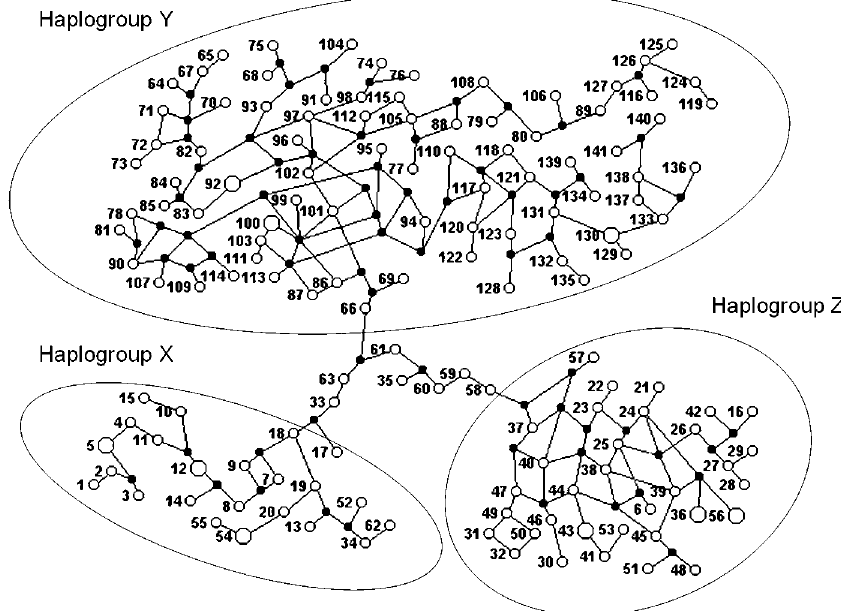
Figure 4. Median Joining Network of the Haplotypes Identified by the PHASE Software DOI: 10.1371/journal.ppat.0020024.g004 Nuclear genetic typing. Amplification of five previously described microsatellite loci , denominated SCLE10, SCLE11, MCLE01, MCLF10, and MCLG10, was performed as previously described [30]. After the PCR, the amplified microsatellites were loaded on a 6% denaturing polyacrylamide gel and analyzed on an ALF sequencer (GE Healthcare, Milwaukee, Wisconsin, United States) using the Allelinks software (GE Healthcare). To determine the allele size the samples were directly compared with the band sizes from an allelic ladder prepared by amplification of an artificial mixture of DNA from 60 T. cruzi strains.